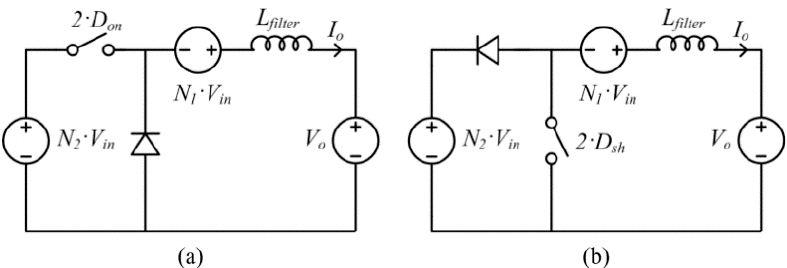
Figure 4. Equivalent circuits of the BiDUP converter for the ( a ) forward and ( b ) backward